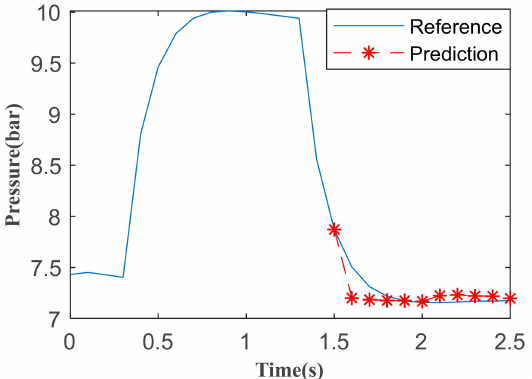
Figure 13. Brake intensity prediction results using the open-loop NARX network (memory order = 5, neuron number = 20) with 10 prediction horizon